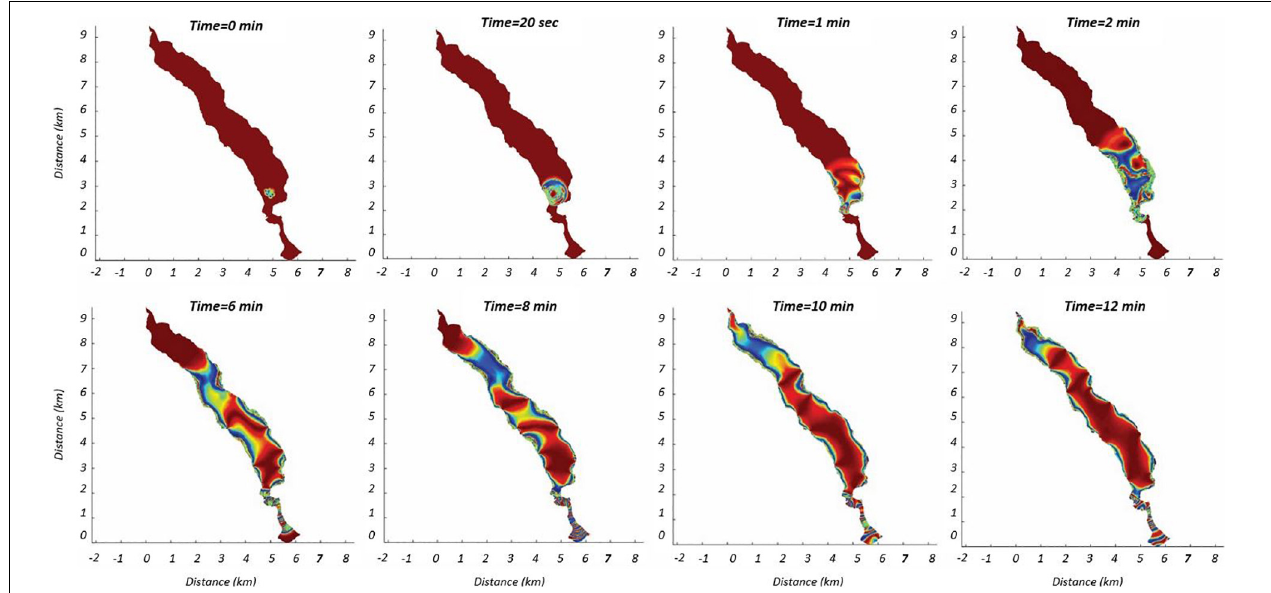
FIGURE 8 | Maps of Lake Lovatnet showing the result of the numerical model reconstruction of the 1936 tsunami waves caused by the rock fall at different modeled times (time = zero). The model corroborates historical records conserving the time that passed since the first tsunami wave was generated until it reached the other extreme of the lake (10 min). Please note that the vertical scale of the tsunami is not shown on purpose, since the model is too simplified to provide an accurate prediction.